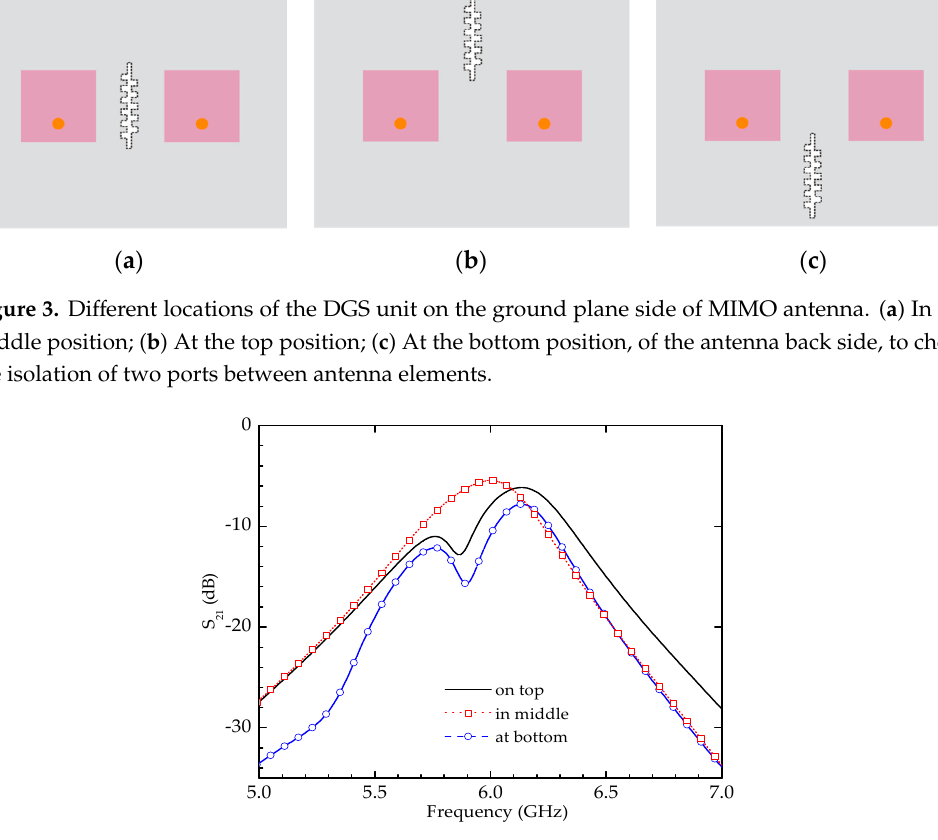
Figure 4. Isolation of two ports between antenna elements for one zigzag groove unit at different locations on the back plane side, in the MIMO antenna, focus on 5.8 GHz.